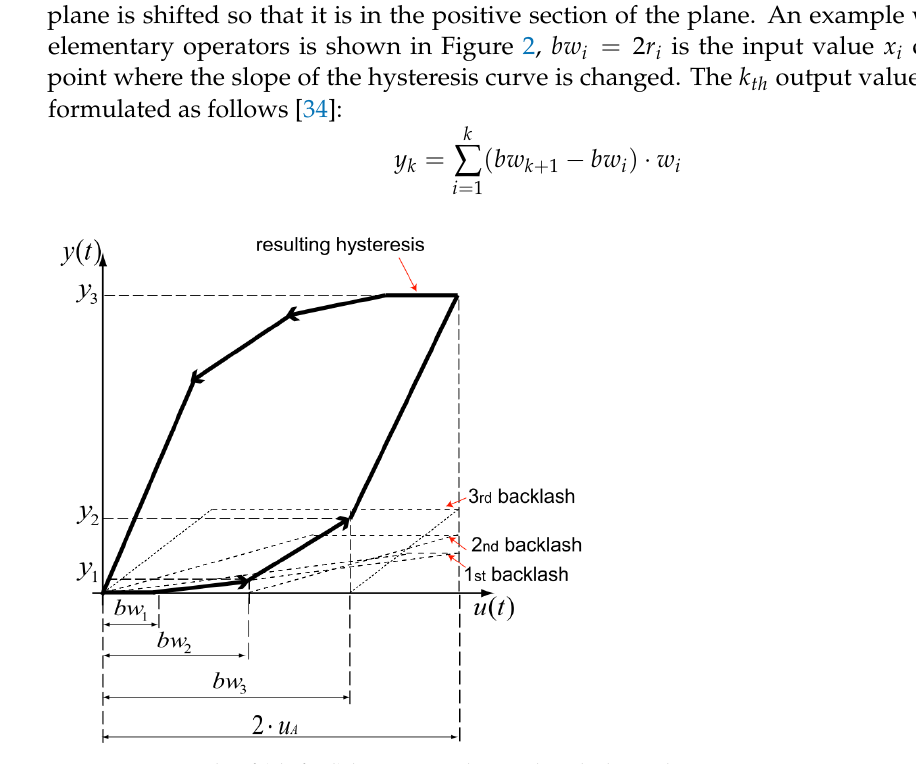
Figure 2. Example of (shifted) hysteresis obtained with three elementary